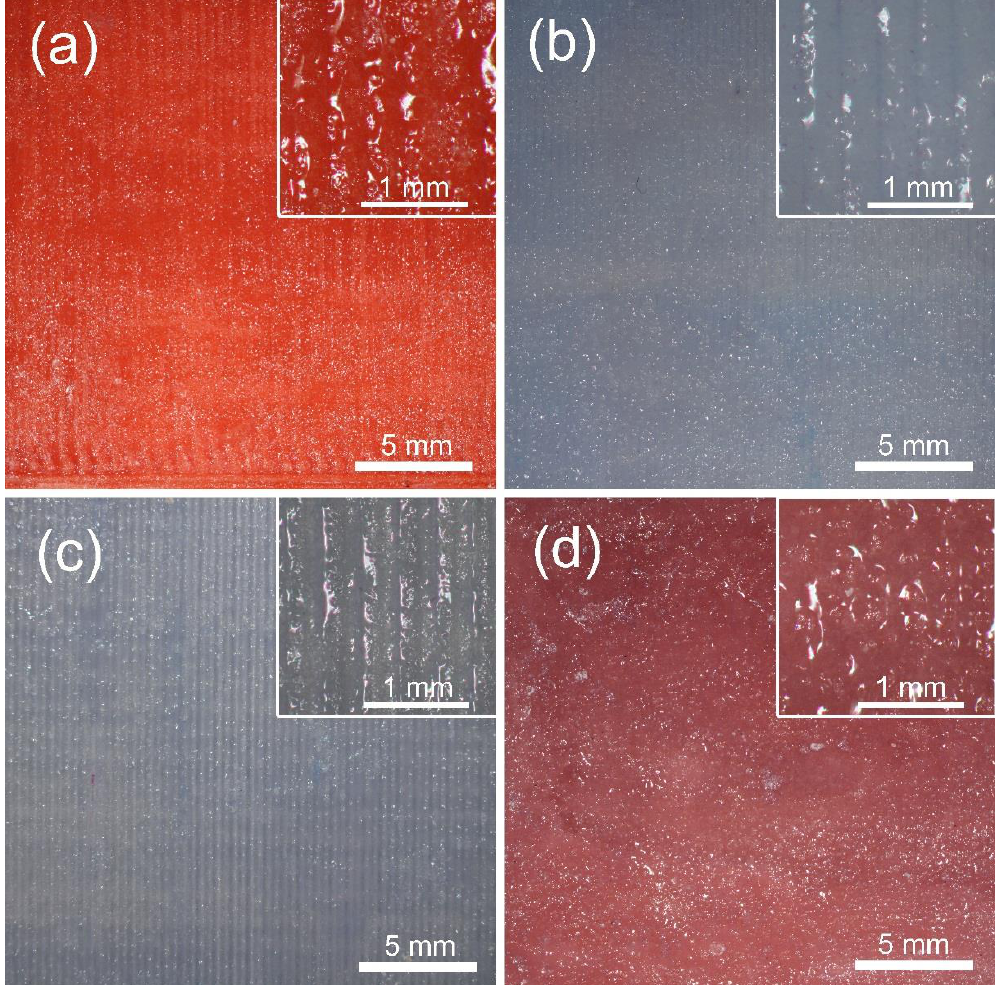
Figure 9. Light microscopical pictures of test surfaces after peeling (6.3 × and 32 × magnification). ( a ) ABS; ( b ) HIPS; ( c ) PETG; ( d ) Reference resin.